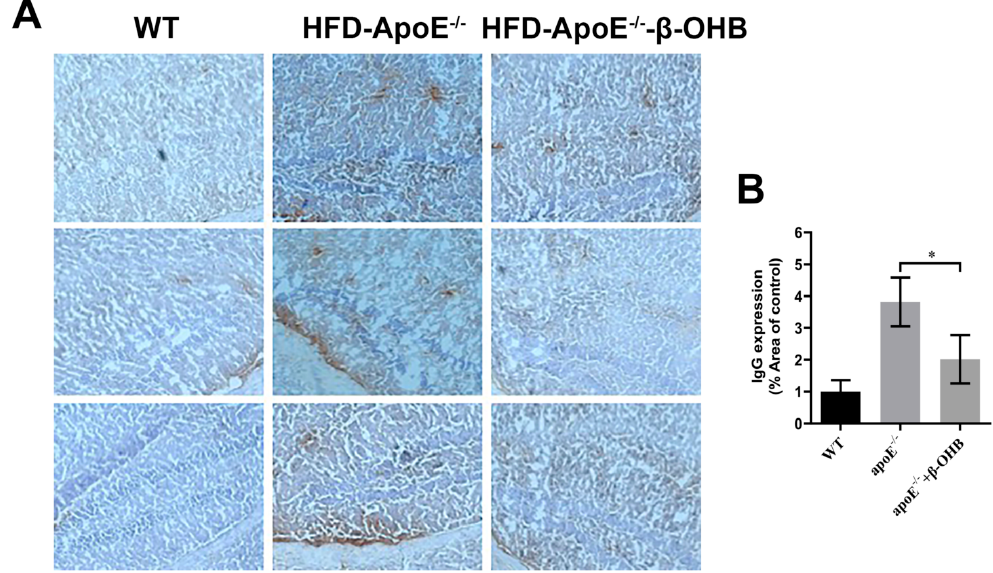
Figure 2. β -OHB decreases IgG extravasation in HFD-ApoE -/- mice. ( A ) Brain sections were stained for mice IgG and counterstained with hematoxylin. ( B ) Quantitative data representations of the percentage of mice IgG staining. WT, normal chow diet-fed C57BL/6J; HFD-ApoE -/- , high fat diet-fed ApoE knock-out; β -OHB, β -hydroxybutyrate; ChP, choroid plexus; V, ventricle. * p < 0.05 vs. HFD- ApoE -/- .